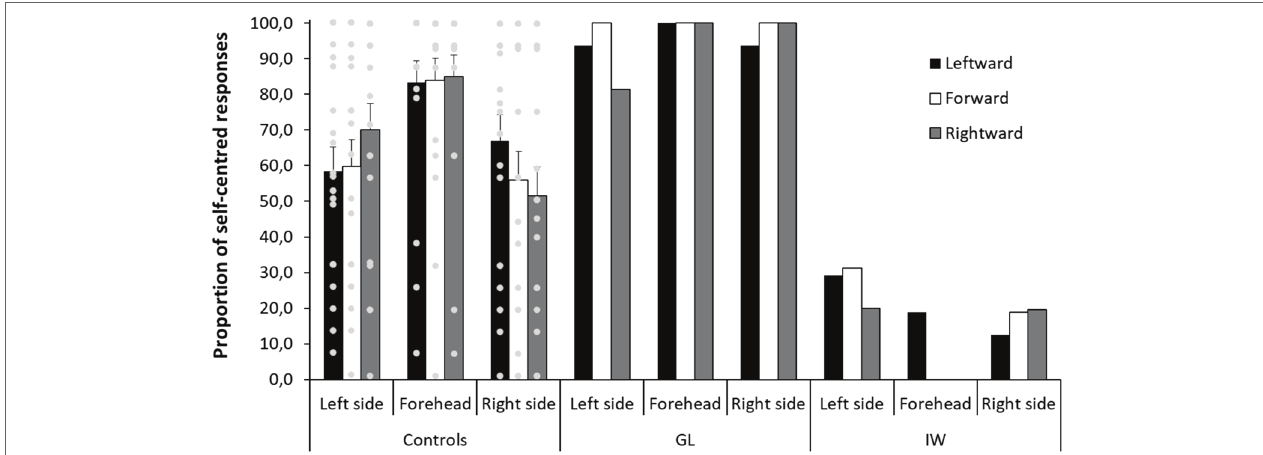
FIGURE 4 | Control participants and patients’ proportion of self-centered responses as a function of the stimulated surface (left side, forehead, right side) and the orientation of the head (leftward, forward, rightward). The gray circles represent the controls’ individual data. Error bars represent the standard errors of the mean for control